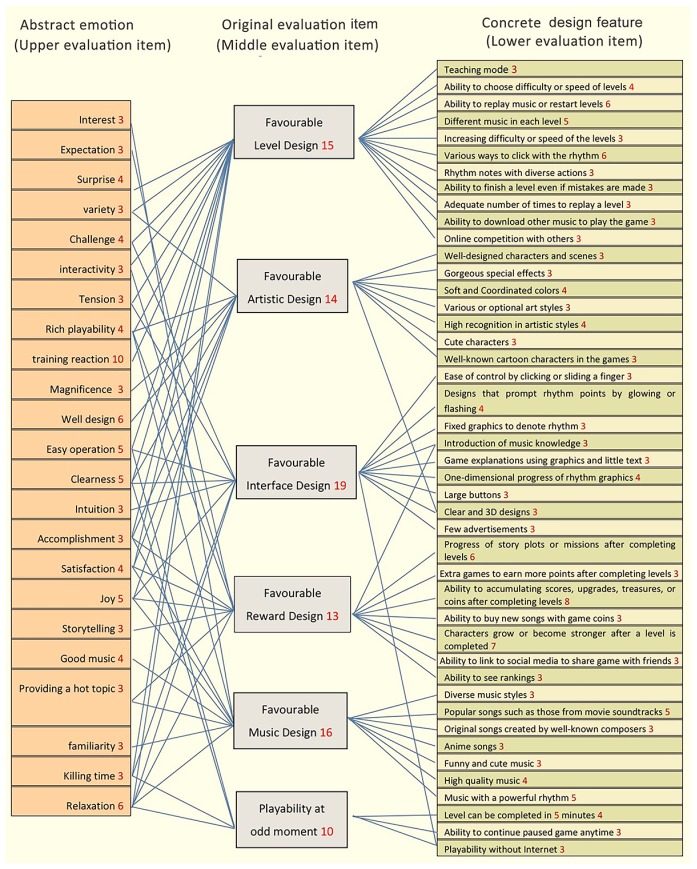
EGM of music games.